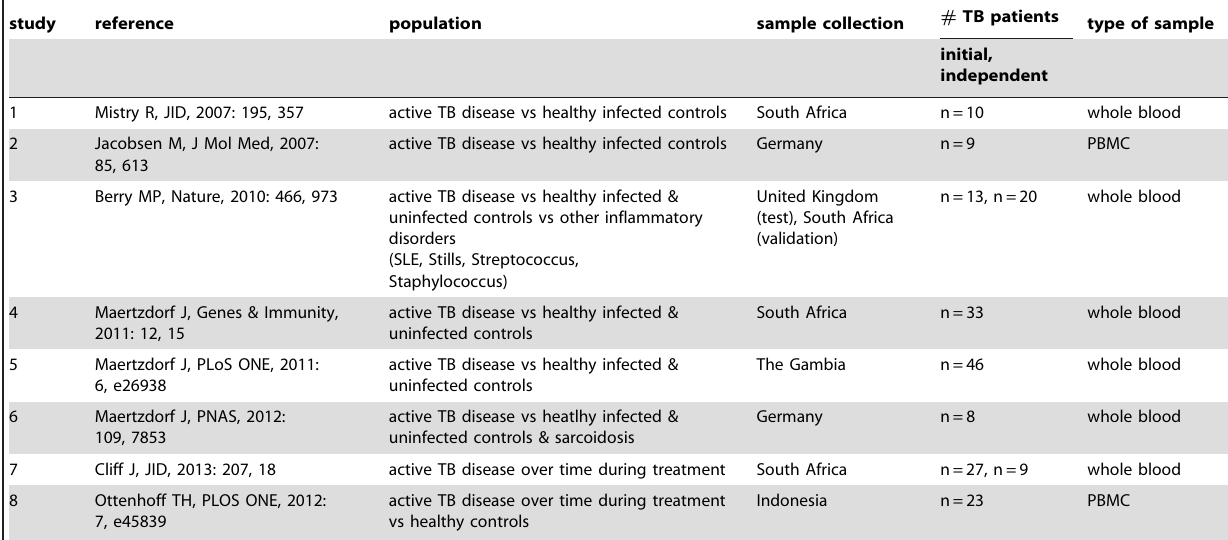
Table 2. Information on studies